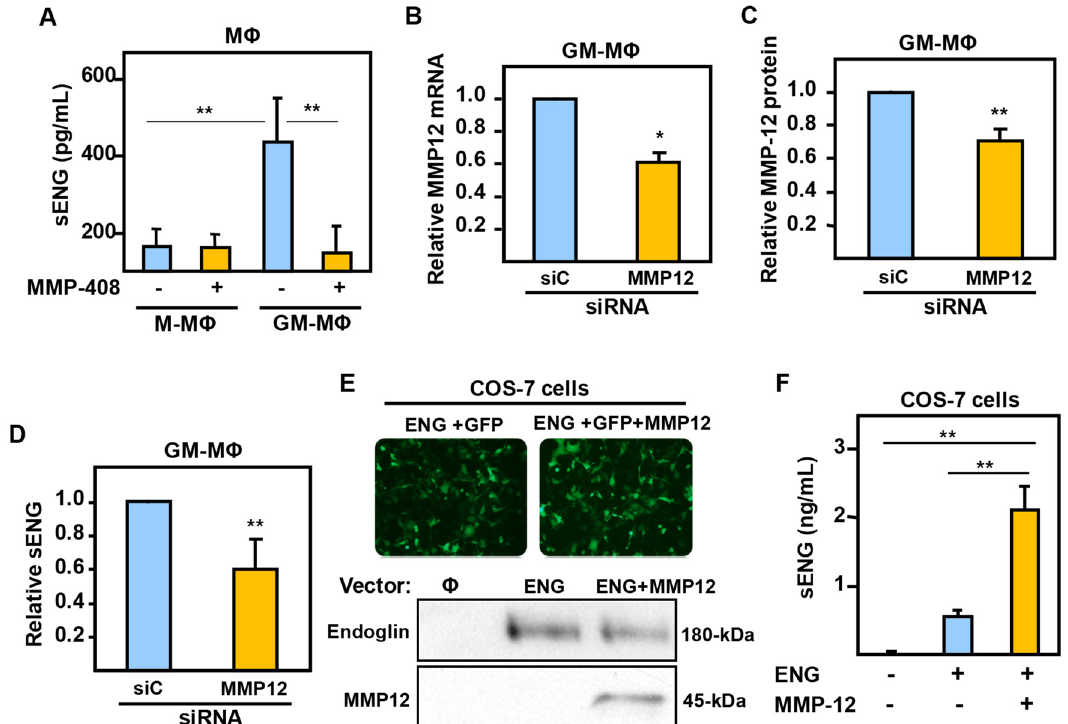
Figure 5. Expression of M Φ soluble endoglin induced by MMP-12. ( A ) E ff ect of the MMP-12 specific inhibitor MMP-408 on the release of soluble endoglin during in vitro macrophage polarization of human monocytes. ( B – D ) E ff ect of MMP-12 silencing in GM-M Φ . GM-M Φ were transfected with siRNA targeting MMP-12 or negative control (siC). After 48 h, MMP-12 mRNA ( B ) and protein ( C ) levels were determined by qRT-PCR and ELISA, respectively. Soluble endoglin levels were also measured in GM-M Φ culture supernatants ( D ). ( E , F ) Recombinant expression of MMP-12 releases soluble endoglin from membrane bound endoglin. COS-7 cells were co-transfected with endoglin (ENG), GFP, and MMP-12, as indicated. Transfection e ffi ciency was visualized by fluorescence microscopy of GFP-expressing cells ( E , upper panel) and by Western blot analysis ( E , lower panel). A negative control with an empty vector ( Φ ) is included. Soluble endoglin levels were measured by ELISA in culture supernatants from transfected COS-7 cells. Statistical analysis was calculated using the paired two-tailed Student t test ( n = 4), and data are presented as mean ± SD. (* p < 0.05; ** p <